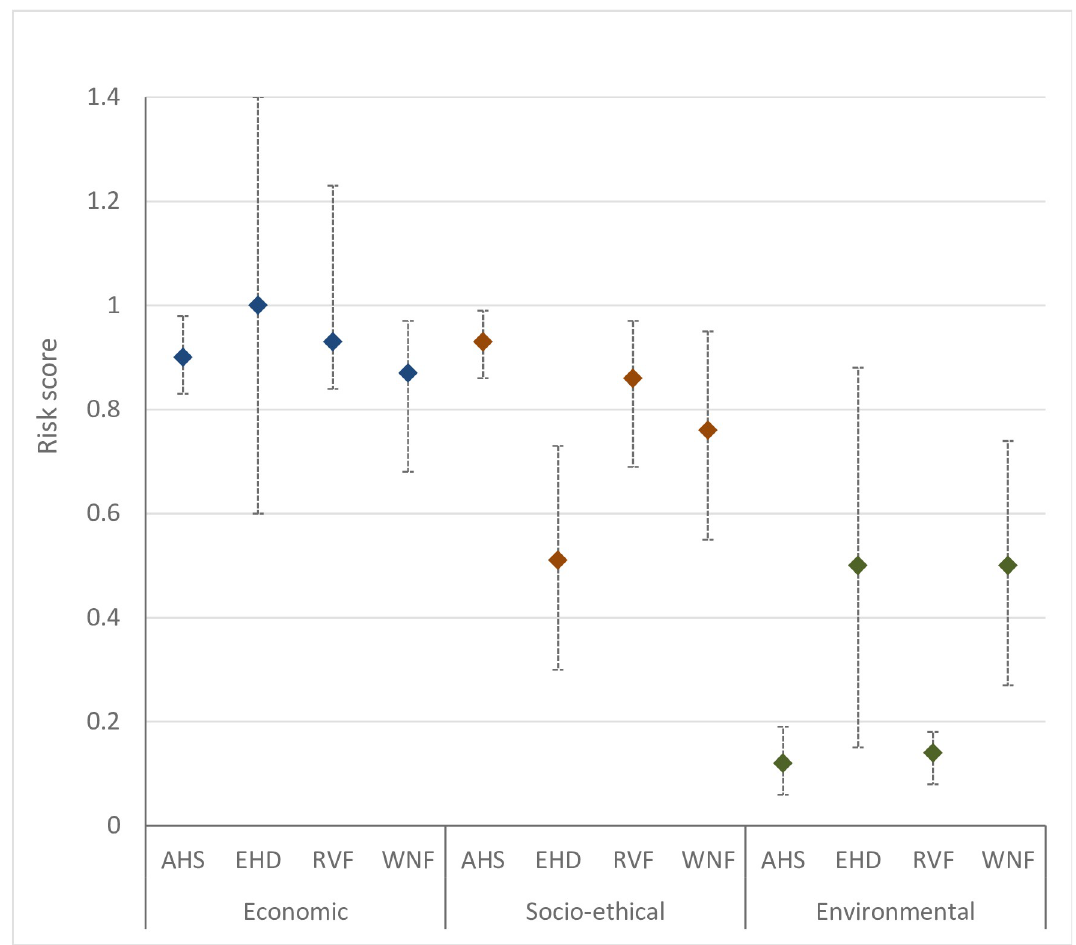
Fig 5. Risk scores (median values) and their uncertainty (95% uncertainty interval) for the estimated impact of four vector- borne diseases for the Netherlands. AHS = African horse sickness; EHD = epizootic haemorrhagic disease; RVF = Rift Valley fever; WNF = West Nile